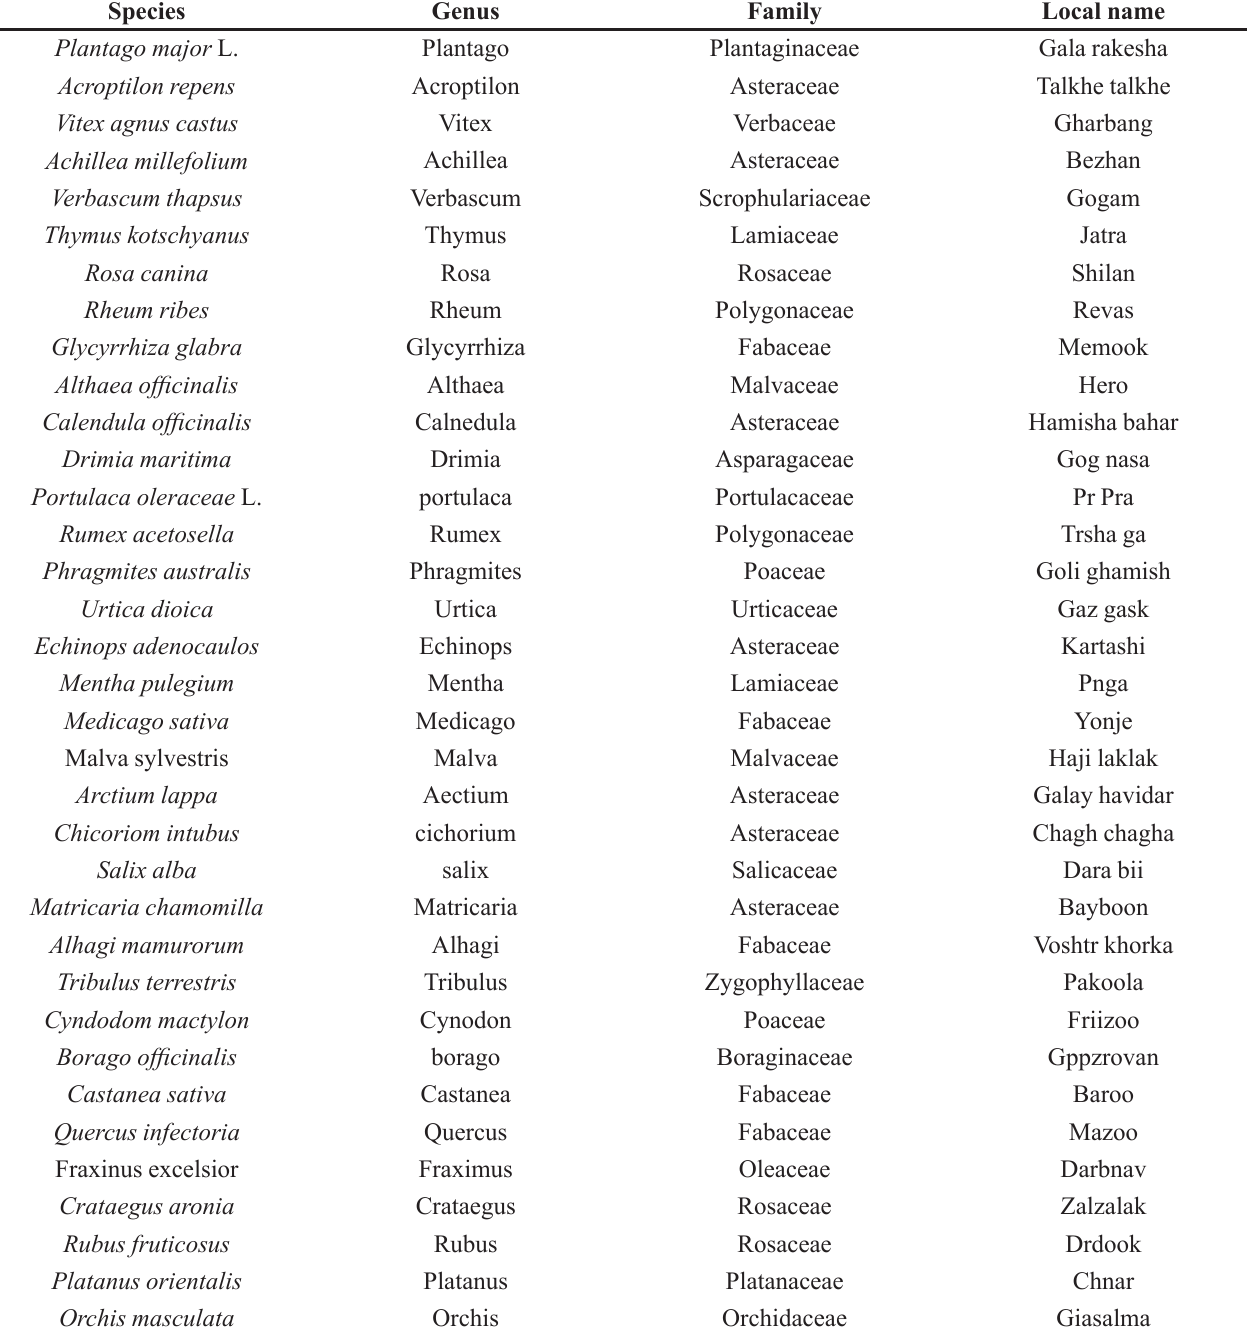
TABLE III - Genus and species of the